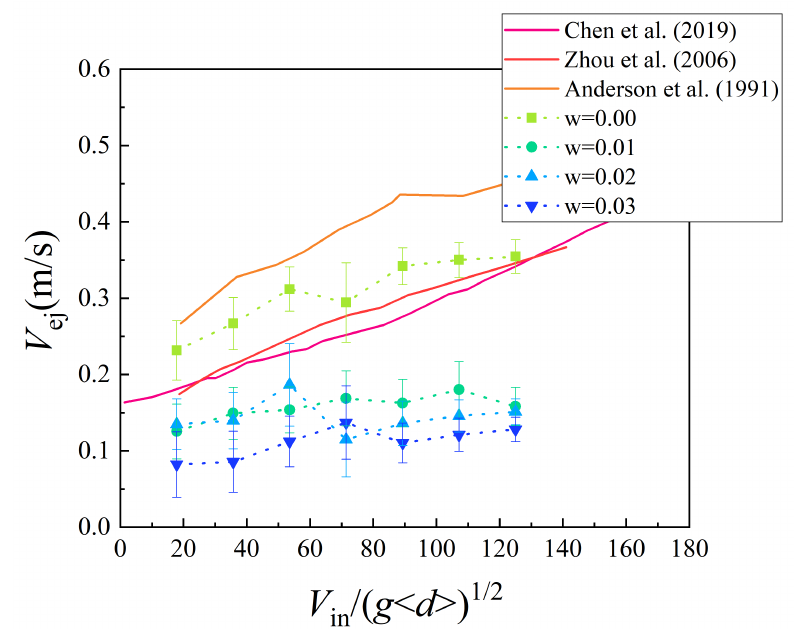
Figure 9. The eject velocities by incident grains in sand-bed collisions under different surface moisture values.